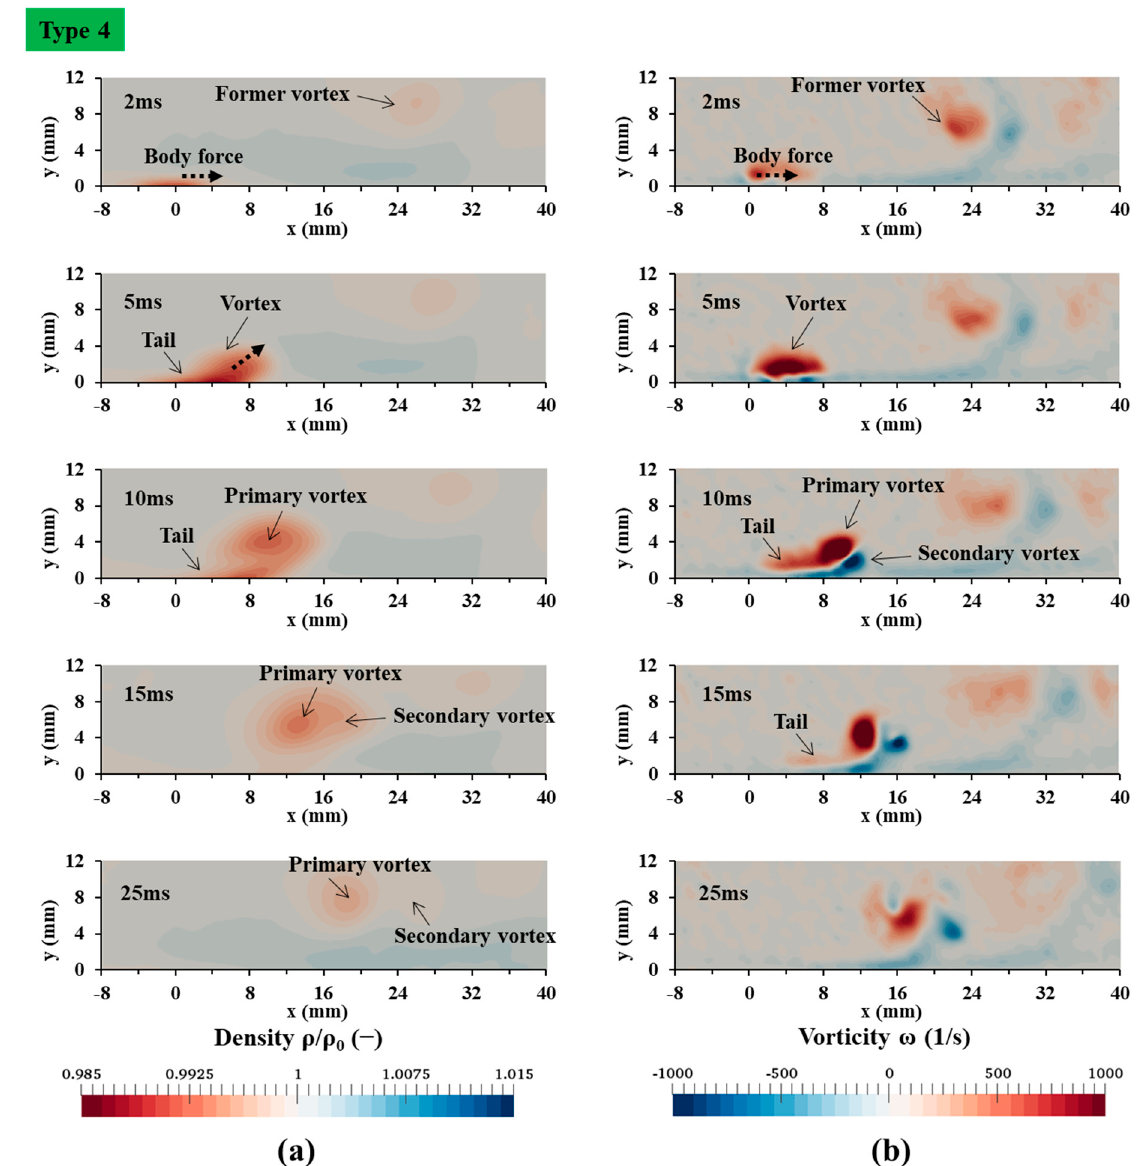
Figure 11. Time-series of ( a ) density field and ( b ) vorticity field contours in burst modulation at F = 7.2 kHz, BR = 20% and T on = 8 ( f + = 25 Hz), 2, 5, 10, 15, and 25 ms after turning on the burst signal input.